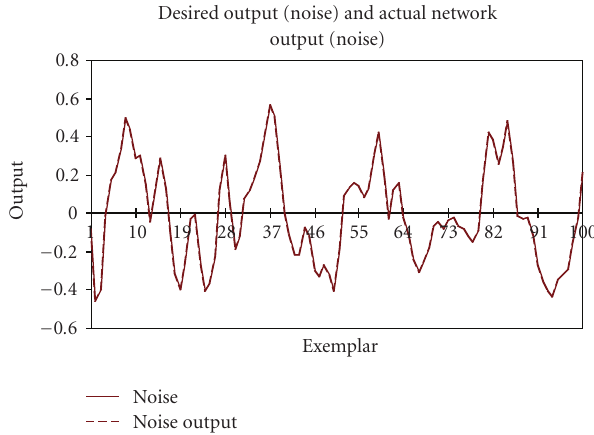
Figure 7: Variation of average of minimum MSE for 5 runs versus number of PEs in the first hidden layer.